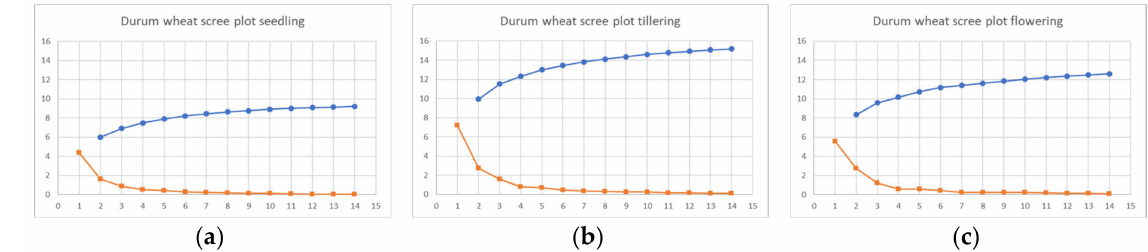
Figure A1. Scree plot of durum wheat cultivars at seedling ( a ), tillering ( b ), and flowering ( c